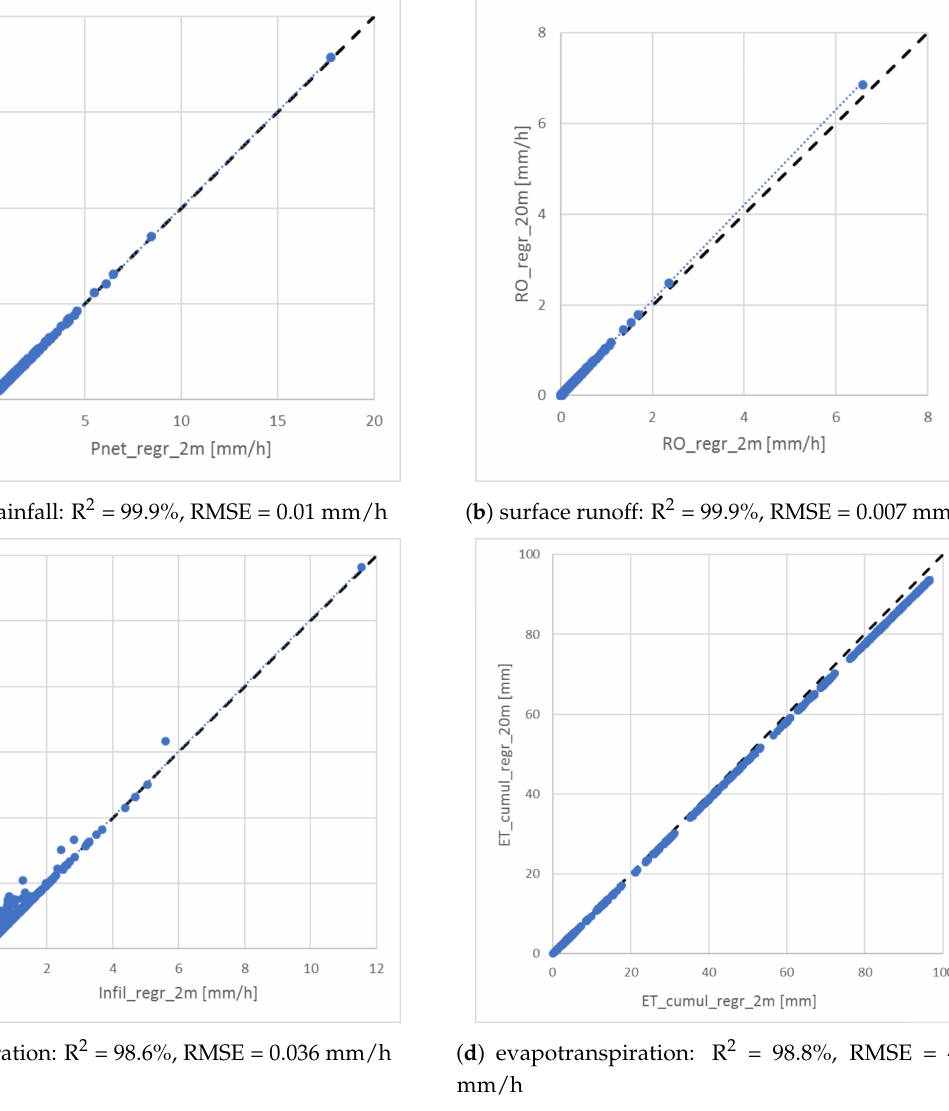
Figure 13. Hydrological surface fluxes: 2 m vs. 20 m regression method.